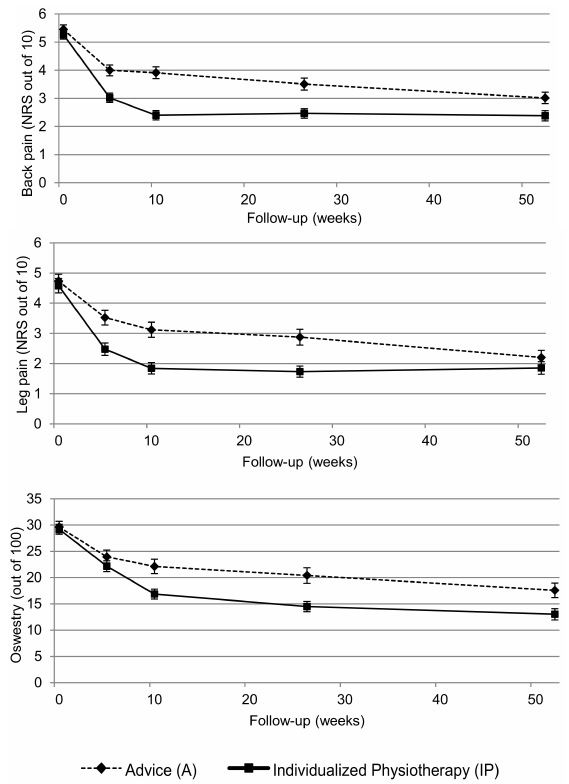
Figure 2. Group mean scores (error bars indicate standard errors) for primary outcomes at baseline and 5-, 10-, 26- and52-weekfollow-upinthe STOPSTrial (adaptedfrom Ford etal.[43],